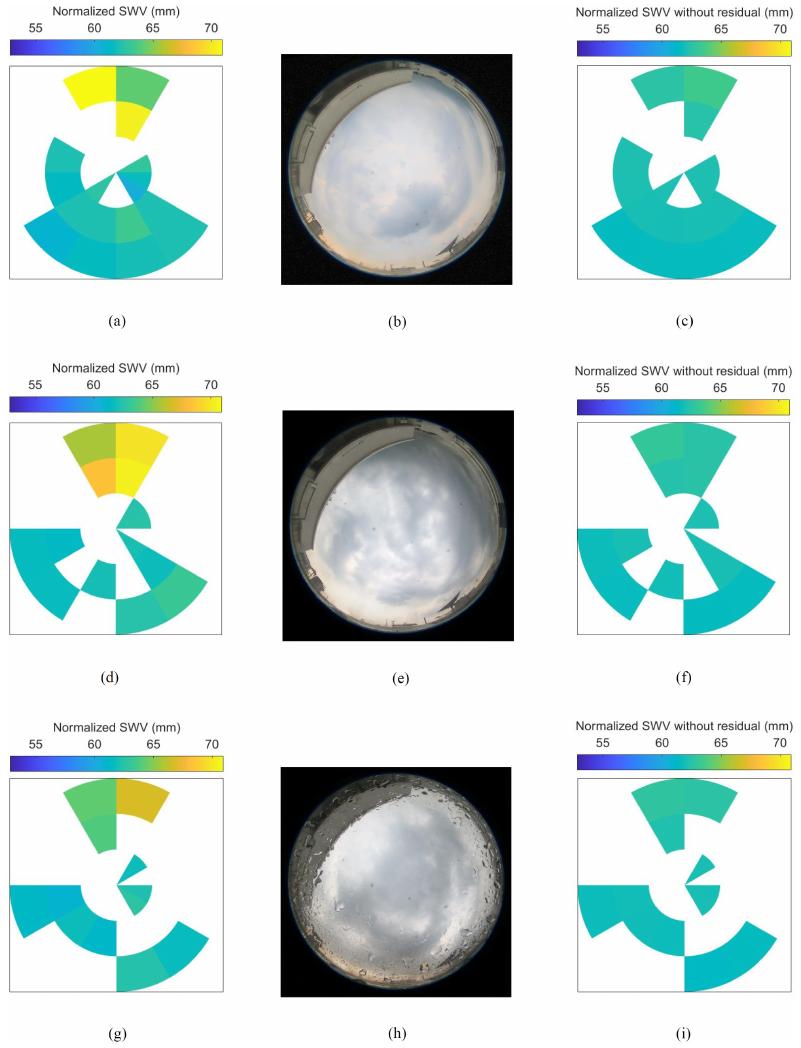
Figure 8. Left: Spatial plots of normalized SWV on 16 April 2016 at ( a ) 17:00, ( d ) 17:20, and ( g ) 17:40 local time. Center: Sky images on the same day at ( b ) 17:00, ( e ) 17:20, and ( h ) 17:40 local time. Right: Spatial plots of normalized SWV without added residual on the same day at ( c ) 17:00, ( f ) 17:20, and ( i ) 17:40 local